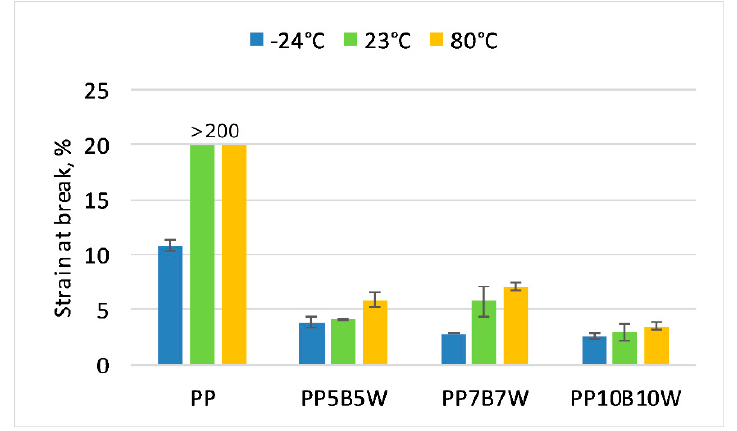
Figure 2. Tensile modulus of the tested materials at − 24 °C, 23 °C, and 80 °C.